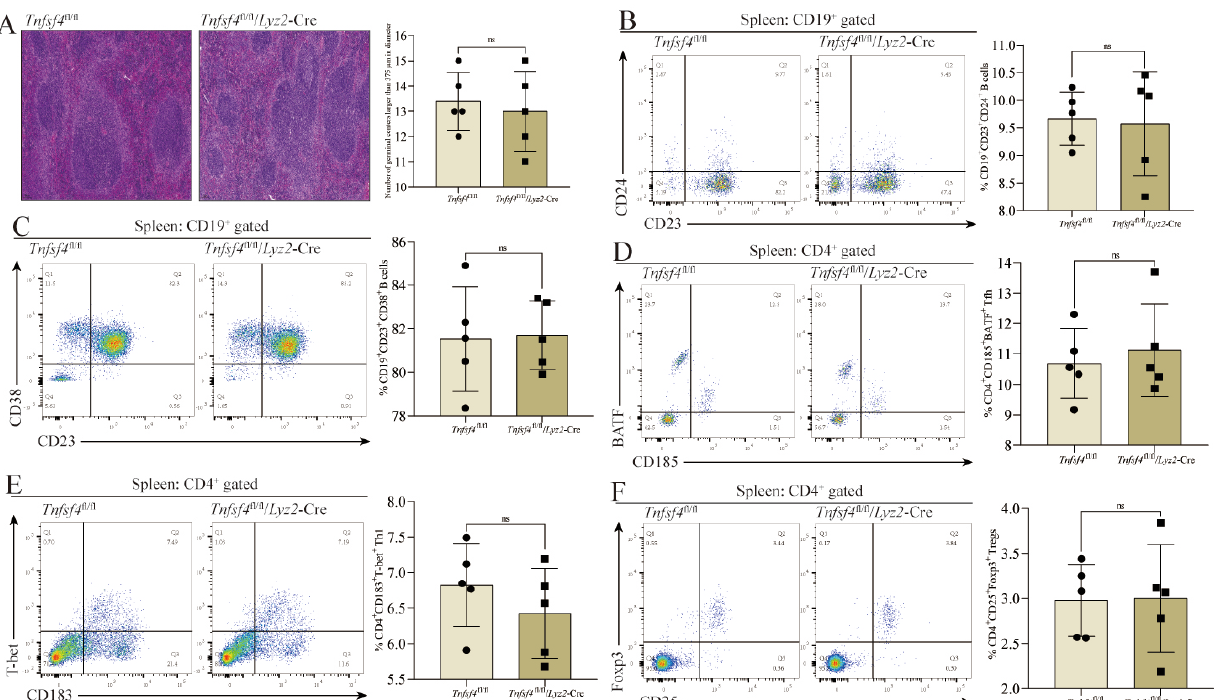
Figure 6. The differentiation of Tfh, Th1, and Tregs does not require macrophages to express OX40L in the CIA mice spleen. ( A ) HE staining of the spleen, and assessment of the size and number of the germinal center. ( B ) The frequency of CD19 + CD23 + CD24 + transitional B cells in the spleen. ( C ) The frequency of CD19 + CD23 + CD38 + follicular B cells in the spleen. ( D ) The proportion of CD185 + BATF + Tfh in CD4 + T cells in the spleen. ( E ) The proportion of CD183 + T-bet + Th1 in CD4 + T cells in the spleen. ( F ) The proportion of CD25 + Foxp3 + Tregs in CD4 + T cells in the spleen. ns means no significant difference between the Tnfsf4 fl/fl /Lyz2-Cre group and the Tnfsf4 fl/fl group. Data represent mean ± SD (unpaired t test was